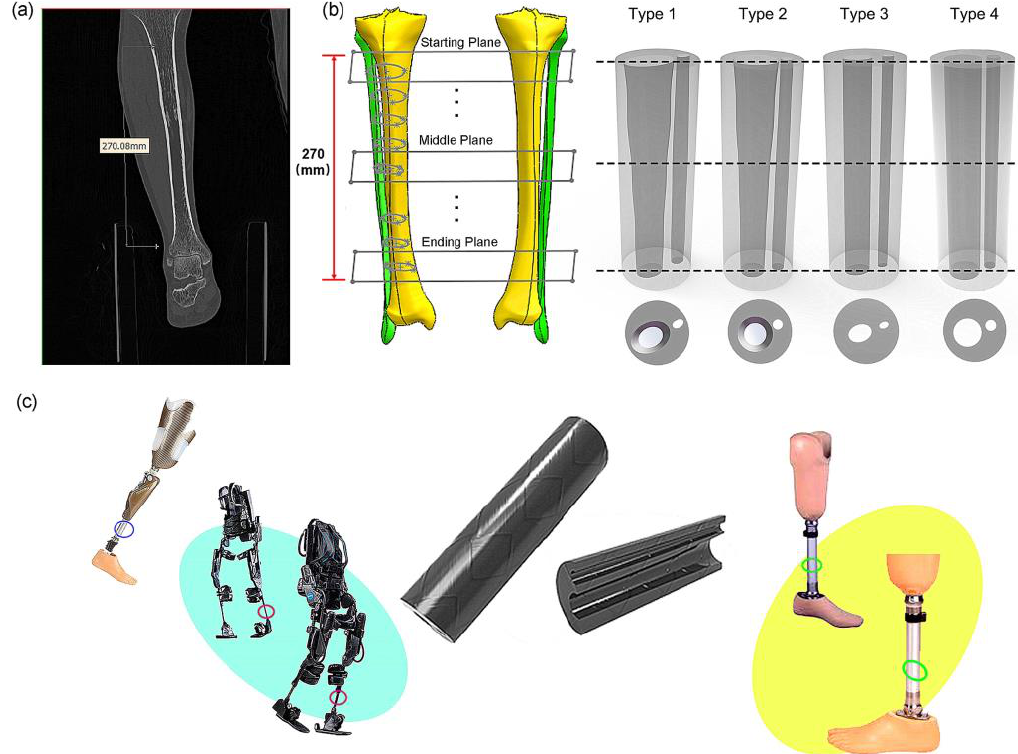
Figure 1. The bionic tube inspired by human tibiofibular bone and its potential applications: ( a ) CT images of human tibia and fibula bones; ( b ) reconstruction of human bones and designs of four bionic tubes; ( c ) potential applications of bionic tubes.